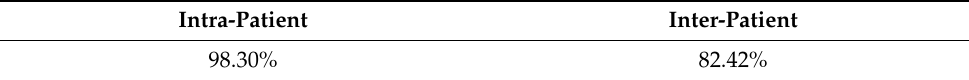
Figure 12. Sample image result of CHDs detection with 4CH view. The white arrow indicates the defect, whereas red and blue colors are the defect position in the heart septum. Table 6. The mAP performance for heart defect